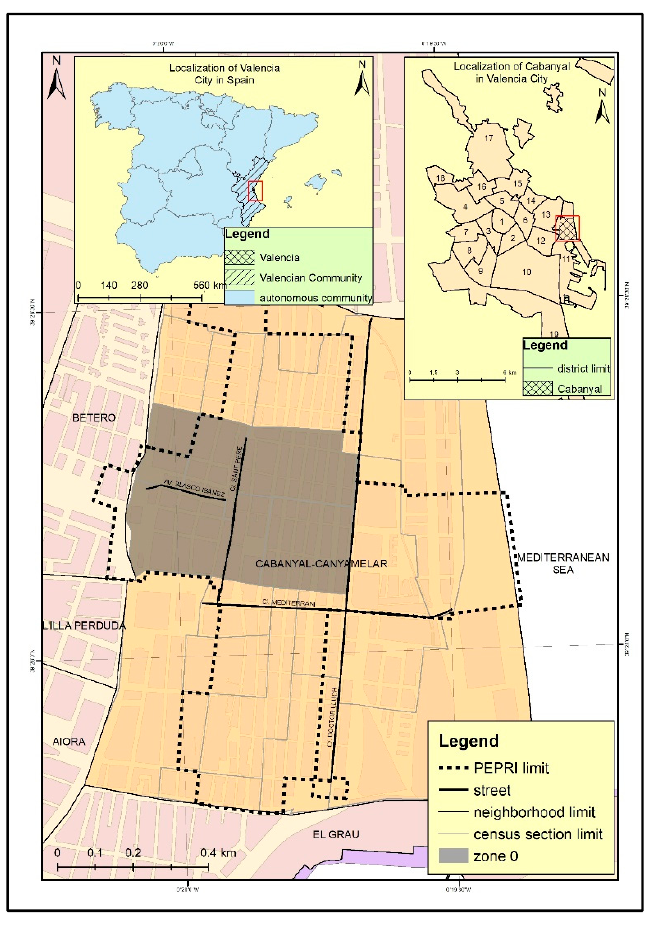
Figure 1. Localization of the Cabanyal neighborhood and zone 0. Data source: [33,34].